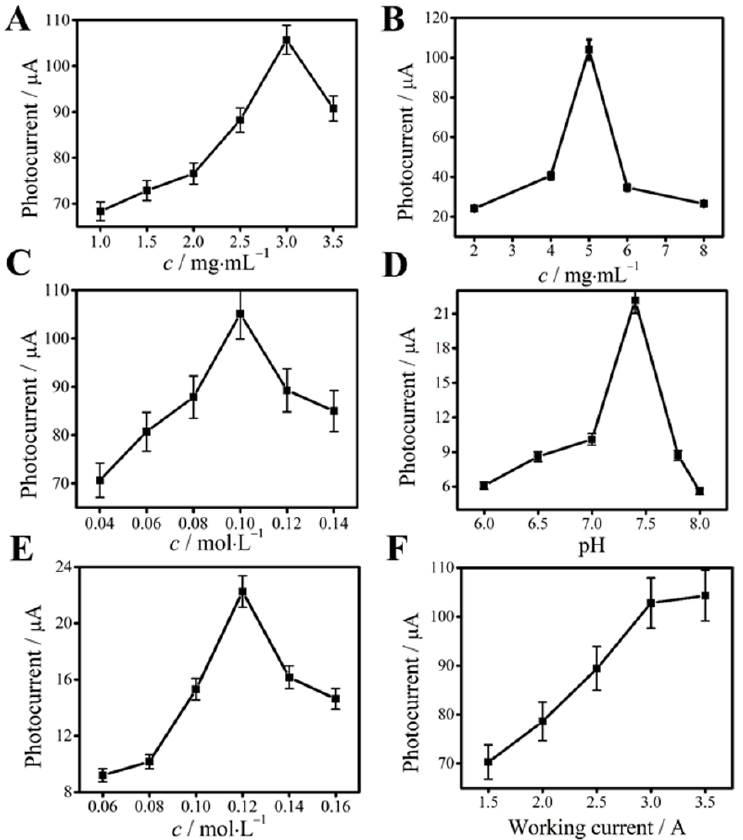
Figure 5. Optimal of concentration of SnO 2 ( A ), BiOI ( B ), AgNO 3 ( C ) and AA ( E ); pH value ( D ); intensity of the light source ( F ). Error bar = SD ( n = 5).